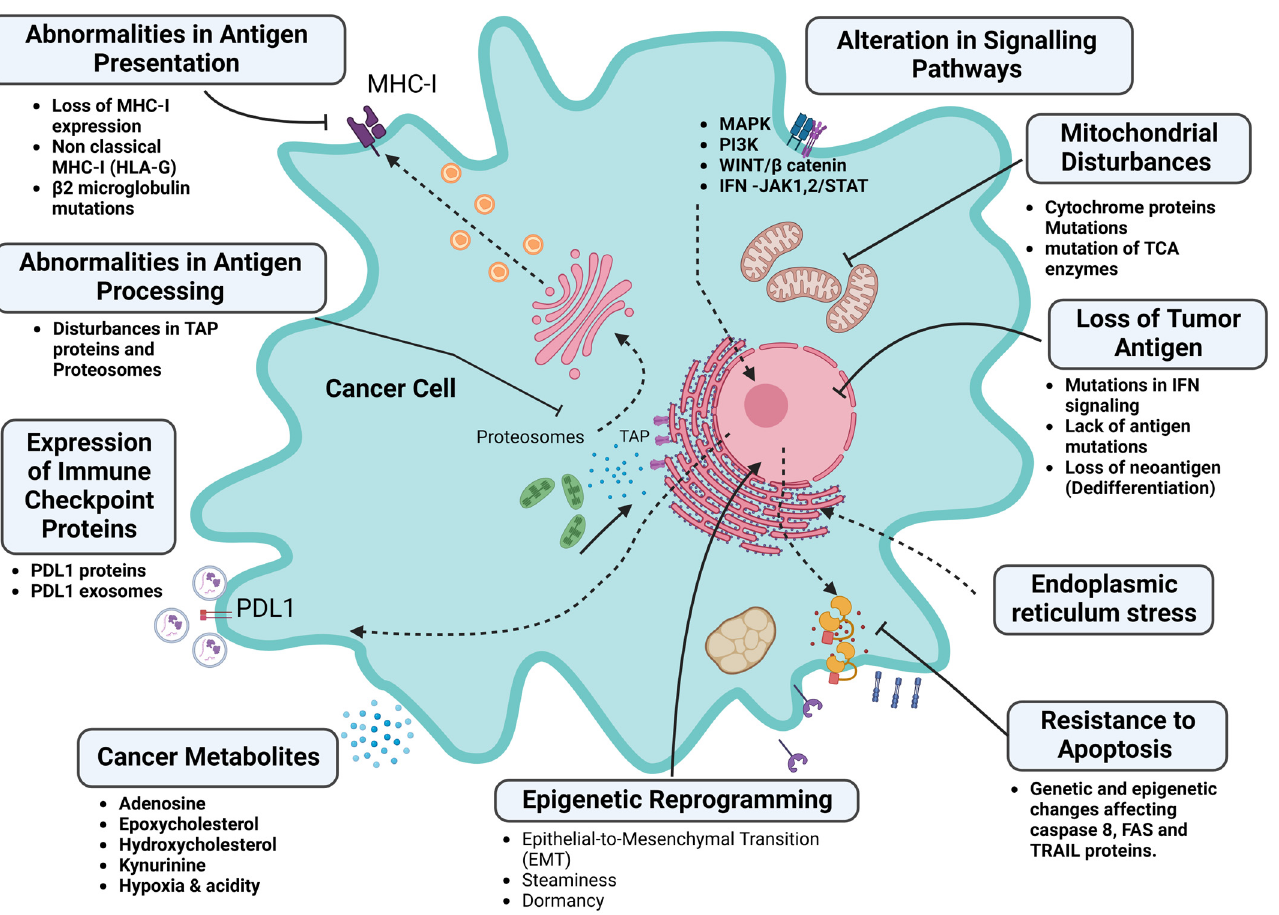
Figure 3. Schematic presentation of the intrinsic tumor factors associated with resistance to im- munotherapy. Multiple mechanisms of cancer resistance to immunotherapy, including (I) loss of neoantigen due to the dedifferentiation or lack of antigen mutations, or mutations in IFN signaling; (II) abnormalities in antigen processing, such as endoplasmic reticulum stress, proteosomes, and TAP protein disturbances; (III) aberrant signaling due to the fact of genetic mutations, such as MAPK, PI3, Wnt/ β catenin, and interferon JAK1,2/STAT pathways; (IV) abnormalities in antigen presentation due to the loss of MHC-1 expression, nonclassical MHC-I expression, or β 2 microglobulin mutations; (V) expression or exocytosis of immune checkpoint proteins, such as PD-L1; (VI) secretion of metabo- lites by cancer cells, such as adenosine, epoxy cholesterol, hydroxy cholesterol, and kynurenine, in addition to hypoxia and acidosis, leading to the modulation of the tumor microenvironment; (VII) epigenetic reprogramming of cancer cells through stemness transformation or EMT changes; (VIII) resistance to apoptosis by the aberrant expression of intrinsic and extrinsic apoptotic pro- teins; (IX) mitochondrial disturbances due to mutations in cytochrome proteins or enzymes in the tricyclic-acetic-acid cycle. Created with